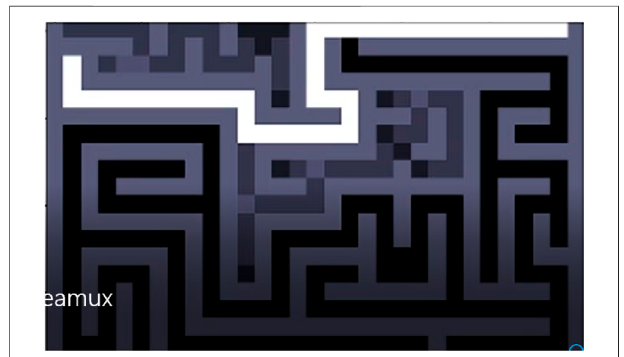
FIGURE 8 | Trémaux algorithm: Path to the